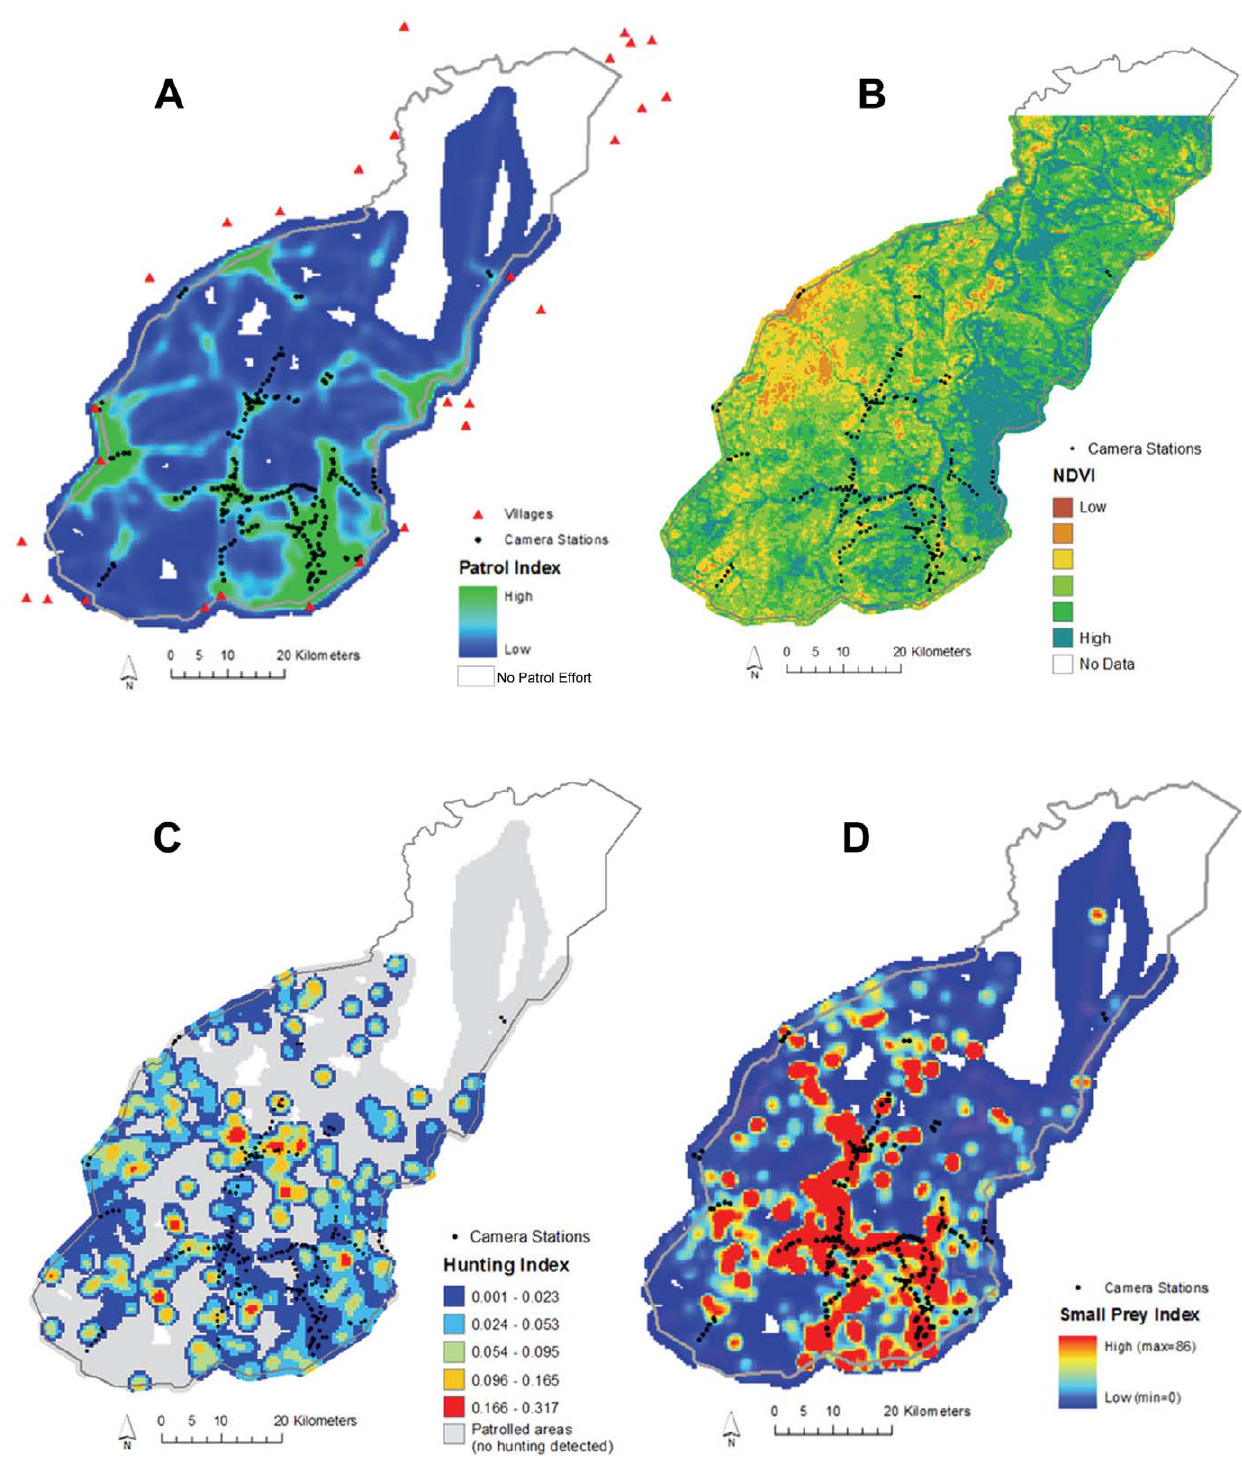
Figure 1. Camera-trap locations ( n=224 ) and indices of patrol effort, hunting activity, habitat, and prey biomass in Mole National Park, Ghana. (A) Index of law enforcement patrol effort (i.e., ‘‘protection’’) calculated as the density of patrol pathways covered between Oct. 2006 and May 2008 (also showing the location of villages within 10 km of the park boundary); (B) NDVI, the normalized difference vegetation index (from MODIS/Terra sensor) summed over the study period (i.e., integrated NDVI, Oct. 2006 – Jan. 2009); (C) Index of illegal hunting activity detected by law enforcement patrols (observations per unit patrol effort); (D) Patrol-based, multi-season index of biomass for prey species weighing less than 18 kg (standardized by patrol effort). No data were obtained in the white areas within the park boundary.